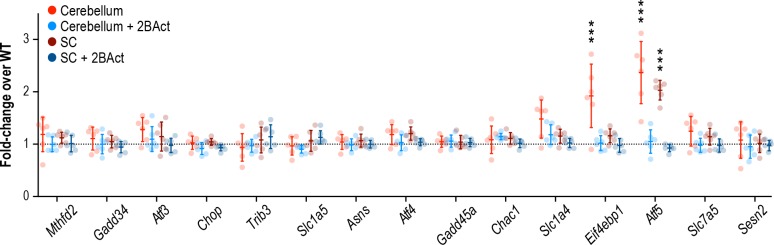
2BAct prevents ISR induction in the cerebellum and spinal cord of Eif2b5R132H/R132H mice.mRNA expression in Eif2b5R132H/R132H cerebellum and spinal cord (N = 6/condition) at 12–14 weeks of age. 2BAct treatment was initiated at 8–10 weeks of age. Data are shown normalized to WT transcript levels. Bars, mean ±SD. ***p<10−5 by Student’s t-test with Holm-Sidak correction (compared to WT). Transcripts without symbols were not significant (p>0.05). A table of p-values from tests is available in Figure 3—source data 1.